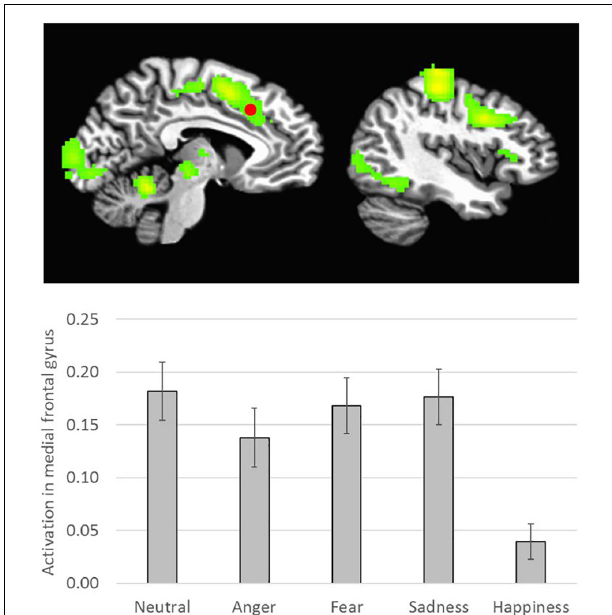
FIGURE 3 | Emotion-specific activation during stimulus presentation (i.e., F of Emotion). Clusters were formed using 3dclustsim at p < 0.001, with a cluster size threshold of 26 voxels. Brain images are rendered in the Talairach-Tournoux template space. Refer to Table 2 for description of regions of activation. Bar graph represents estimated marginal means for effect of Emotion type on activation in the medial frontal gyrus (marked with a red dot on the brain image), with Sex, Relative Closeness, and Age held constant at the mean. Error bars represent the standard error of the